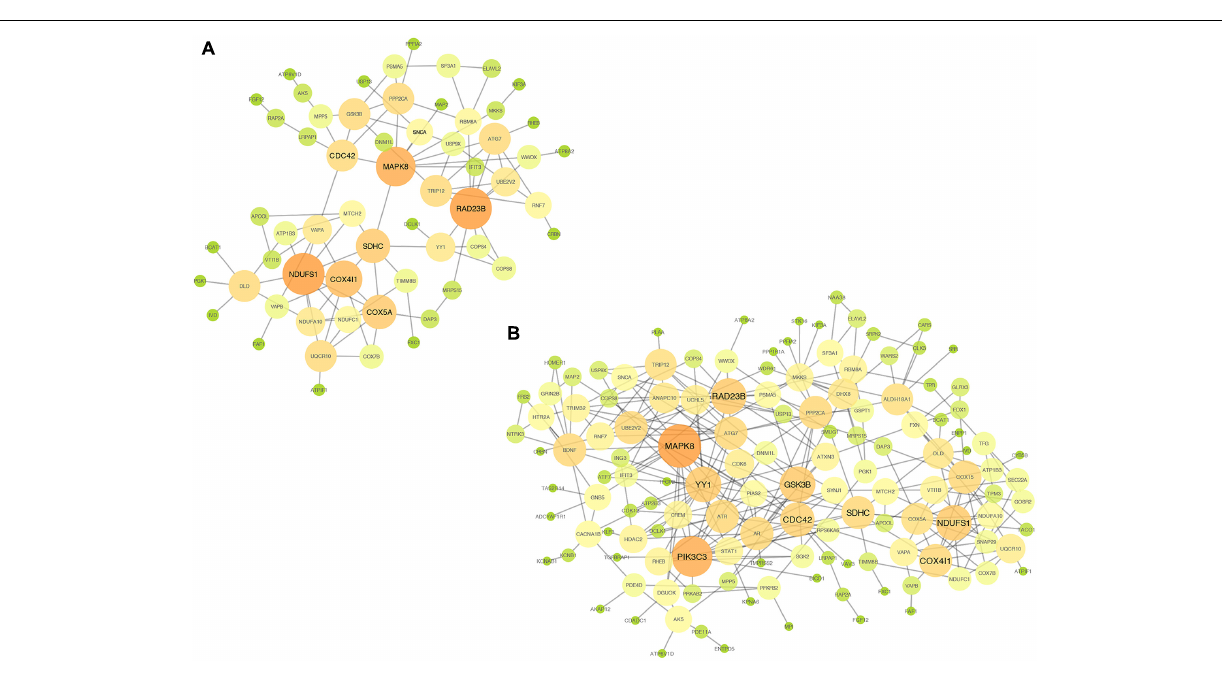
FIGURE 3 | PPI networks. (A) PPI network of overlap DE genes. (B) PPI network of meta-DE genes. The size and color of map nodes are determined by the degree value, which renders a gradual process by setting the small size with a low degree in green, large size with a high degree in